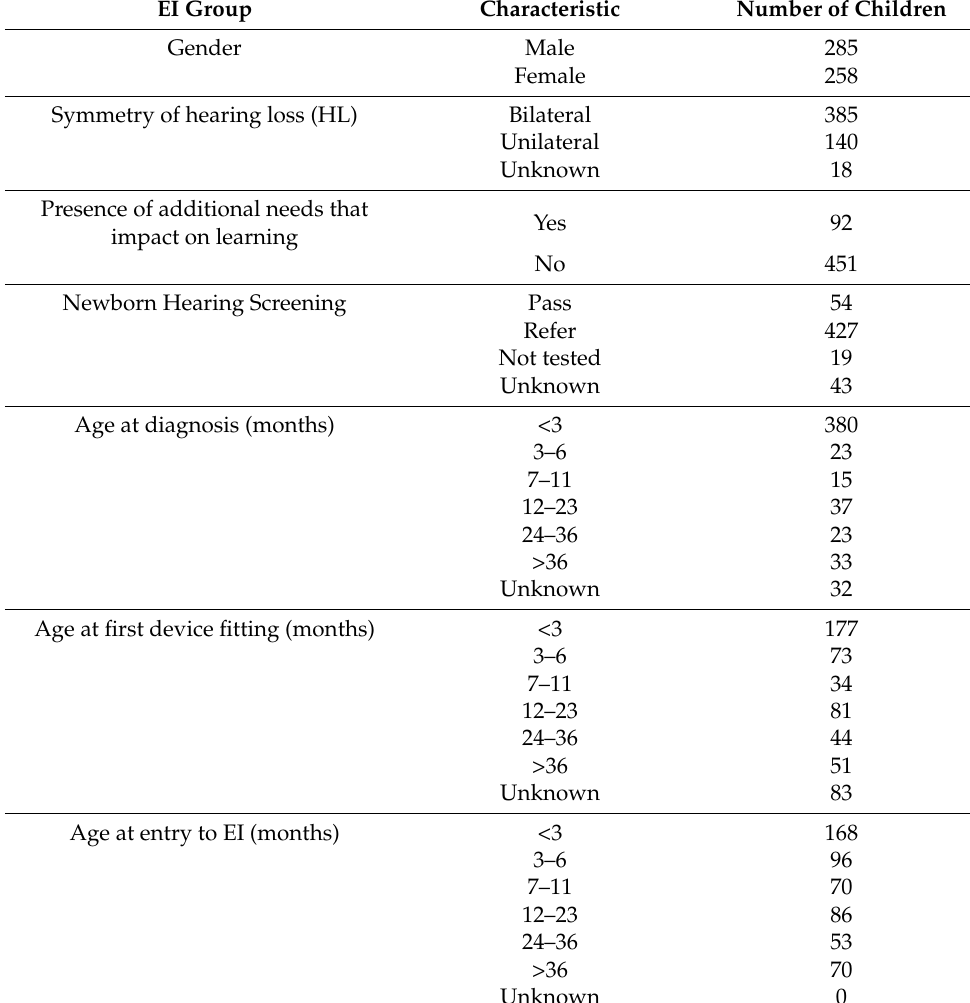
Table 1. Early Intervention (EI) group participant characteristics.